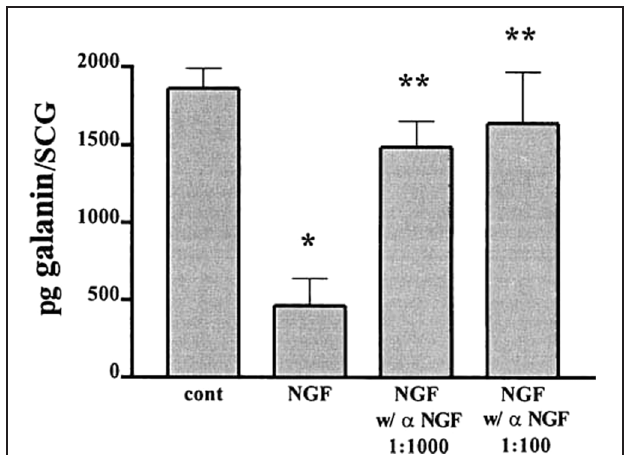
FIGURE 3 | NGF inhibits the increase in galanin-IR and this effect is completely reversed by an NGF antiserum. Adult SCG were cultured for 48h in F12 medium alone or in the presence of 50ng/ml NGF. To some of the NGF-treated cultures we also added different concentrations of an antiserum to NGF. Galanin-IR was assayed by radioimmunoassay in individual SCG. Data are the means of six ganglia ± SEM; ∗ p , 0.004vs. control and ∗∗ p , 0.02vs. NGF. The figure is from Shadiack et al. (2001). and in SCGs (Kiryu-Seo et al., 2000; Boeshore et al., 2004).